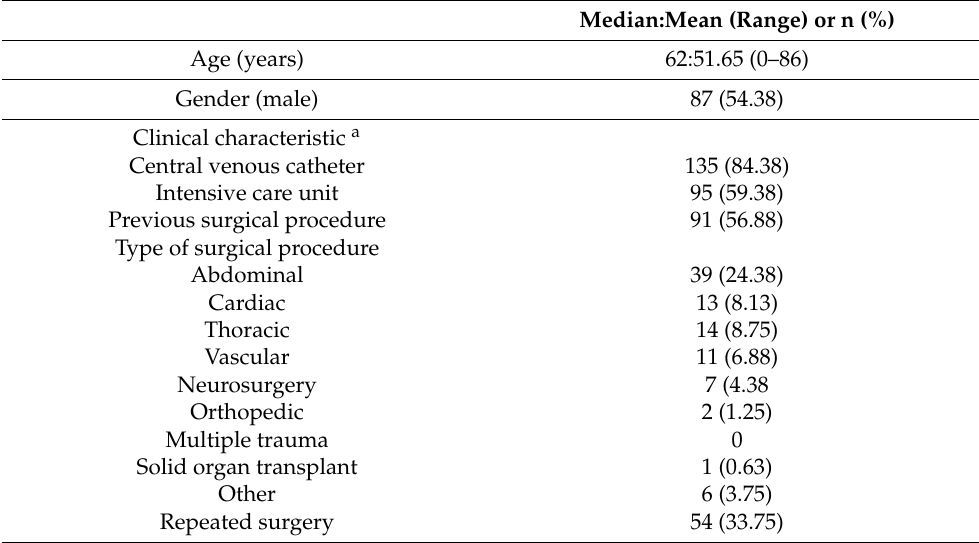
Table 2. Demographic data and clinical characteristics of 160 patients with